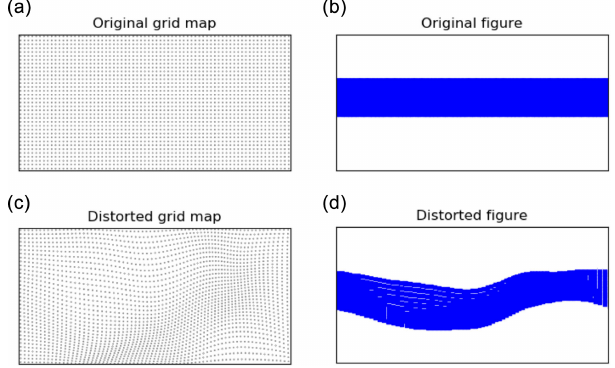
Figure 5. Illustration of grid distortion technique: (a) original grid map, (b) original dust concentrations as band, (c) distorted grid map, (d) distorted dust concentrations.